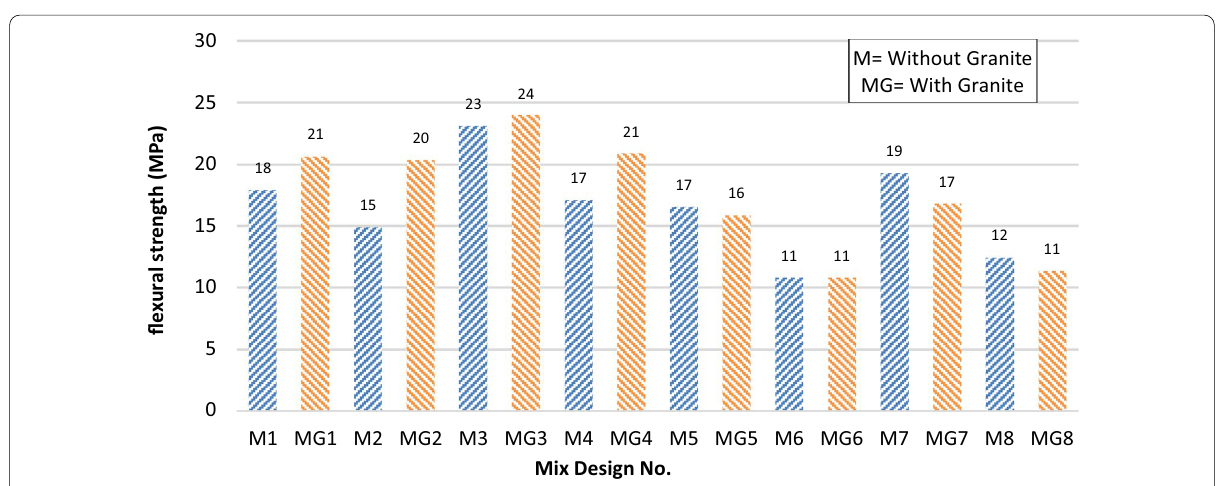
Fig. 5 Flexural strength of mixes with and without GW before